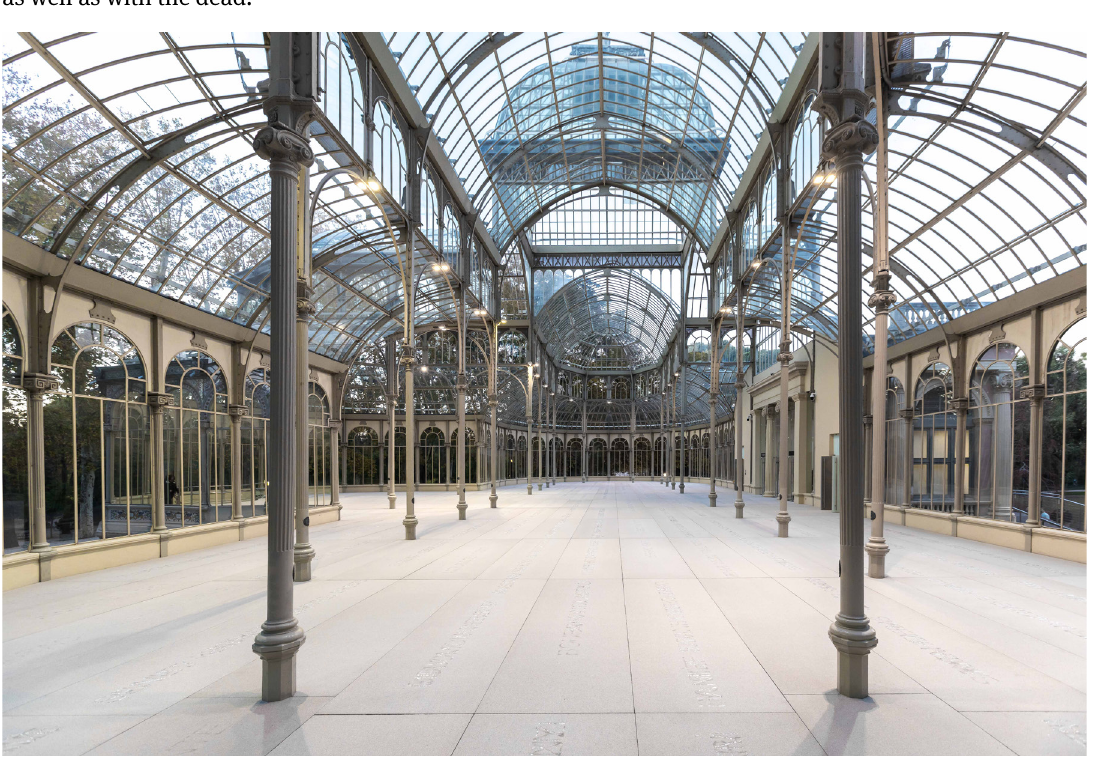
Fig. 21 Doris Salcedo, Palimpsesto 2017 (in the space) Salcedo’s work addresses cultural memory in its negativity, its failure, and seeks to find hints of solutions. Failure of memory is not so much forgetting , a very useful concept we should not “forget” when considering memory; and one which Aleida Assmann, in her book Formen des Vergessen, usefully sums up in the cover text as “a filter, as a weapon and as a prerequisite for the creation of new things.” Instead, Salcedo’s focus is on actively , albeit not necessarily purposely repressing or, in a different view, disassociating —in other words, dis-remembering , as the title of a 2015 work calls it, on the one hand; or willfully, in what can even go as far as bad faith, distorting potentially helpful memories on the other, as mis-remembering . Both are devastating, wasteful, missed opportunities for the present and future. Without moralising, Salcedo counters these